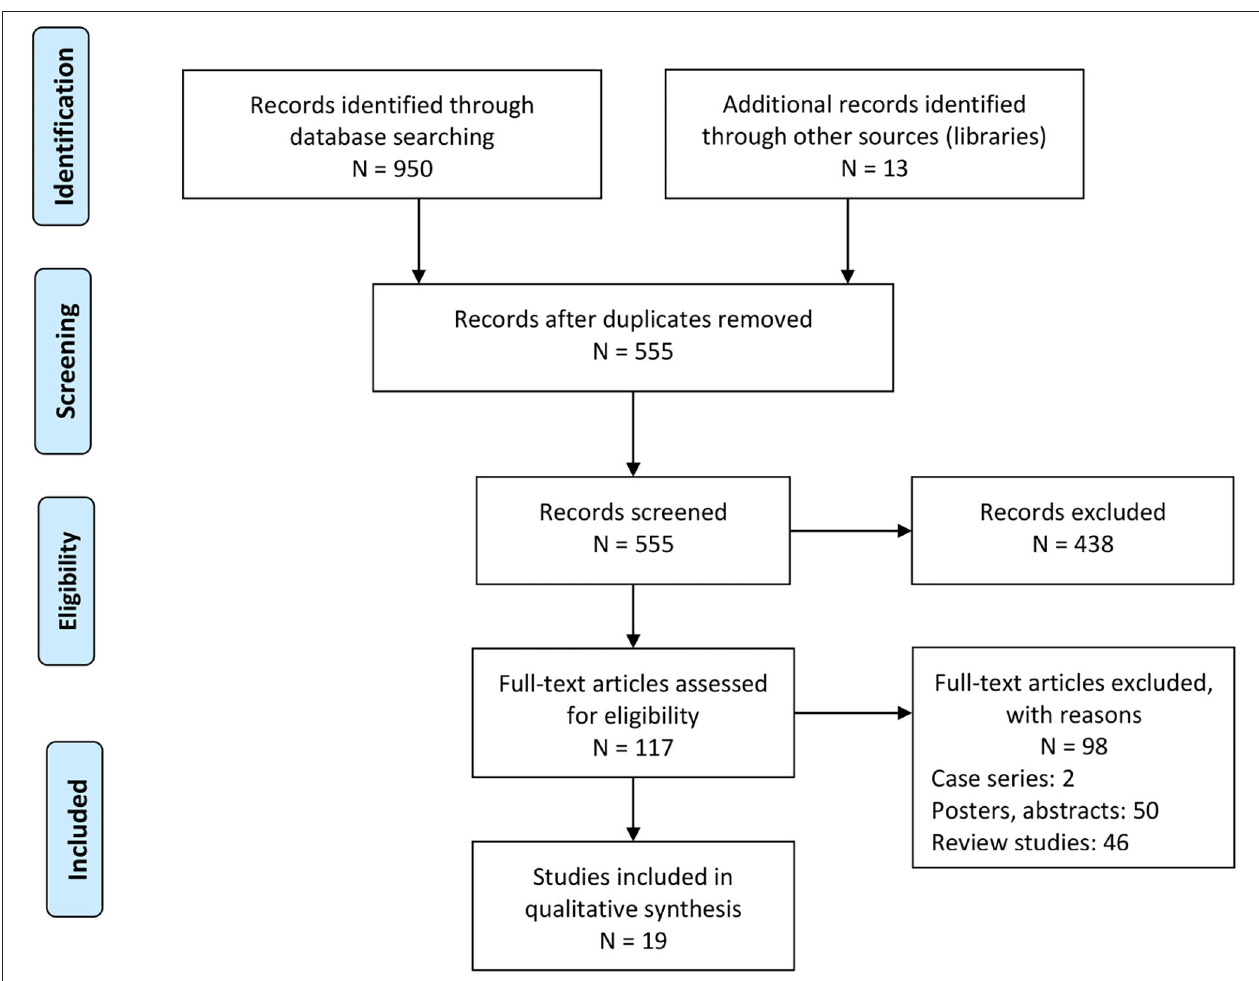
FIGURE 1 | PRISMA flowchart for study